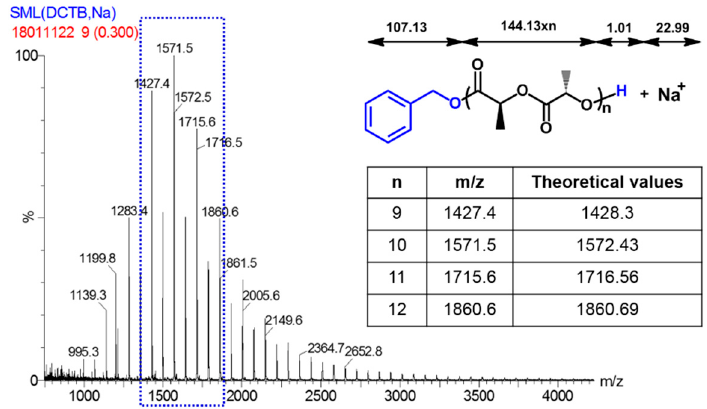
Figure 1. 1 H NMR spectrum of the PLLA catalyzed by Zn( D -Phe) 2 at L -LA/BnOH = 10.